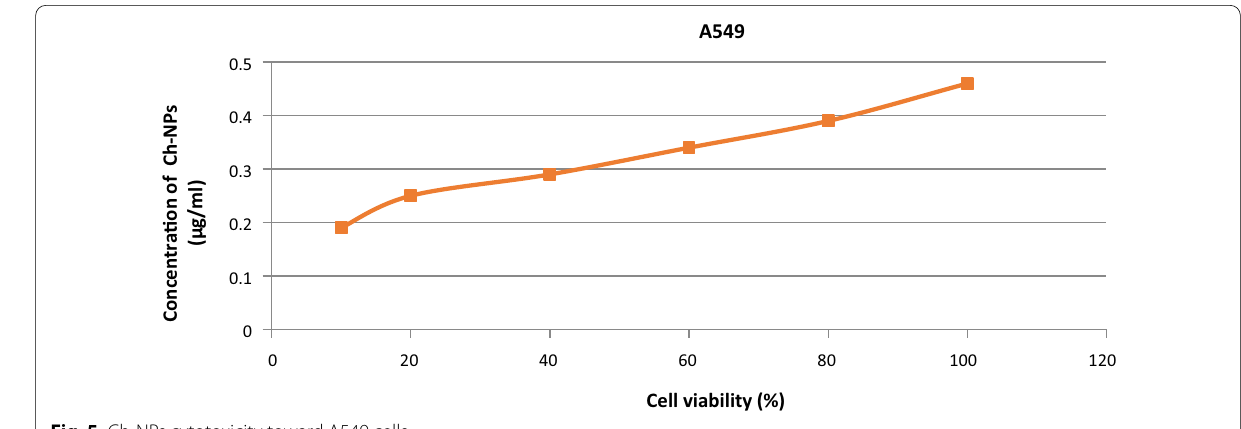
Fig. 5 Ch-NPs cytotoxicity toward A549 cells